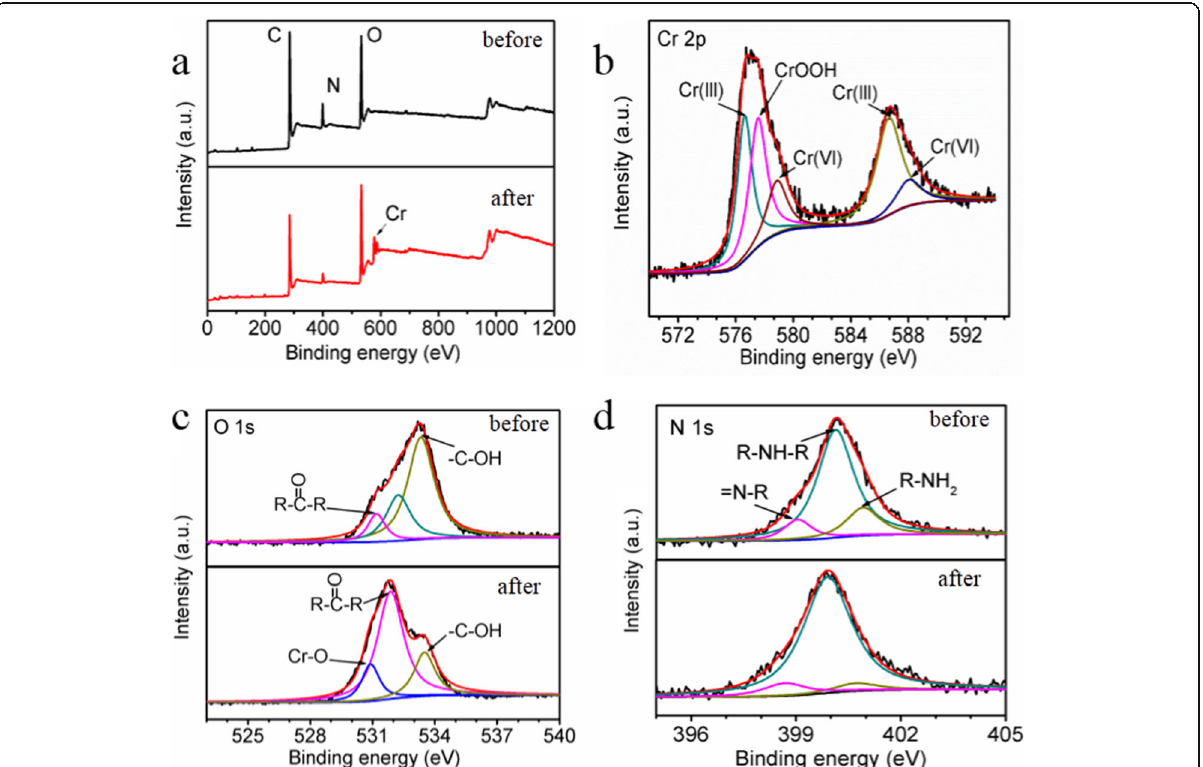
Fig. 6 a XPS spectra investigation of PPMs and Cr(VI)-adsorbed PPMs; b Cr 2p spectral survey to the Cr(VI)-adsorbed PPMs; c O 2p and d N 1 s high-resolution spectra of PPMs and the Cr(VI)-adsorbed